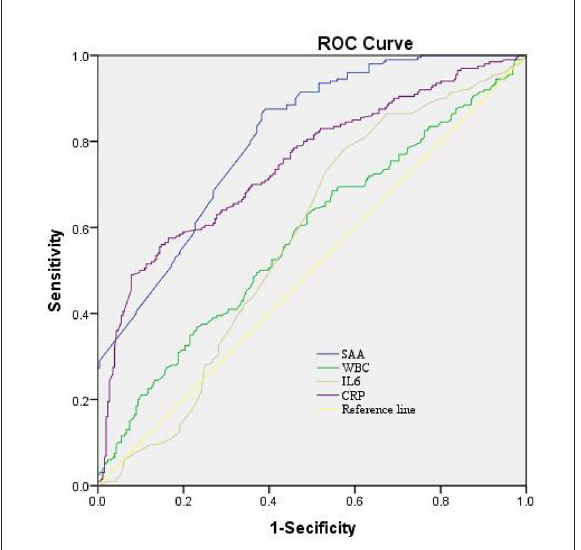
FIGURE3 The ROC curves for the prediction of poor outcome. Predictive values of SAA, CRP, IL-6, and WBC for depression at 3-month after aSAH. AUC 0.573 (95%CI, 0.521–0.626; P = 0.004) for IL-6; 0.748 (95%CI, 0.702–0.794; P = 0.007) for CRP; 0.579 (95%CI, 0.526–0.632; P = 0.004) for WBC; and 0.807 (95%CI, 0.623–0.747; P = 0.004) for SAA. SAA had the COV of 30.28,